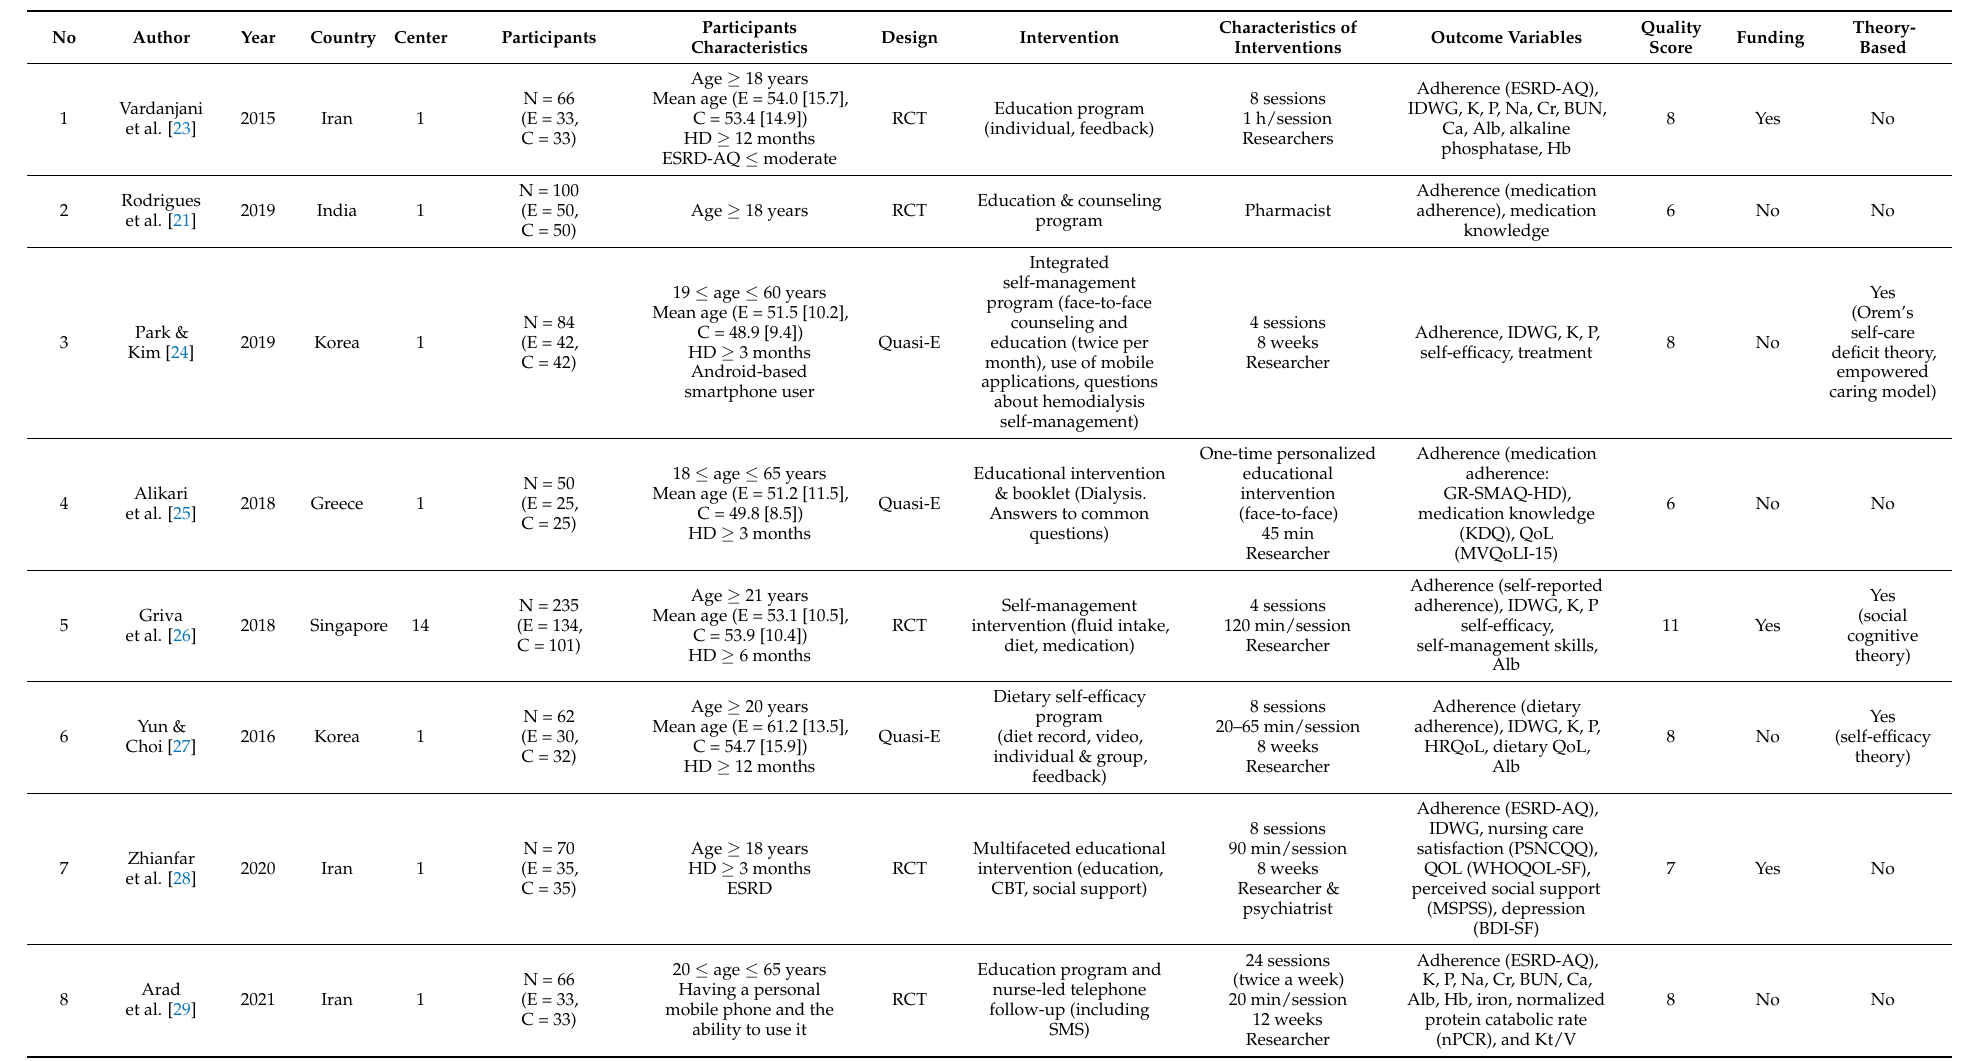
Table 2. Descriptive summary of the included